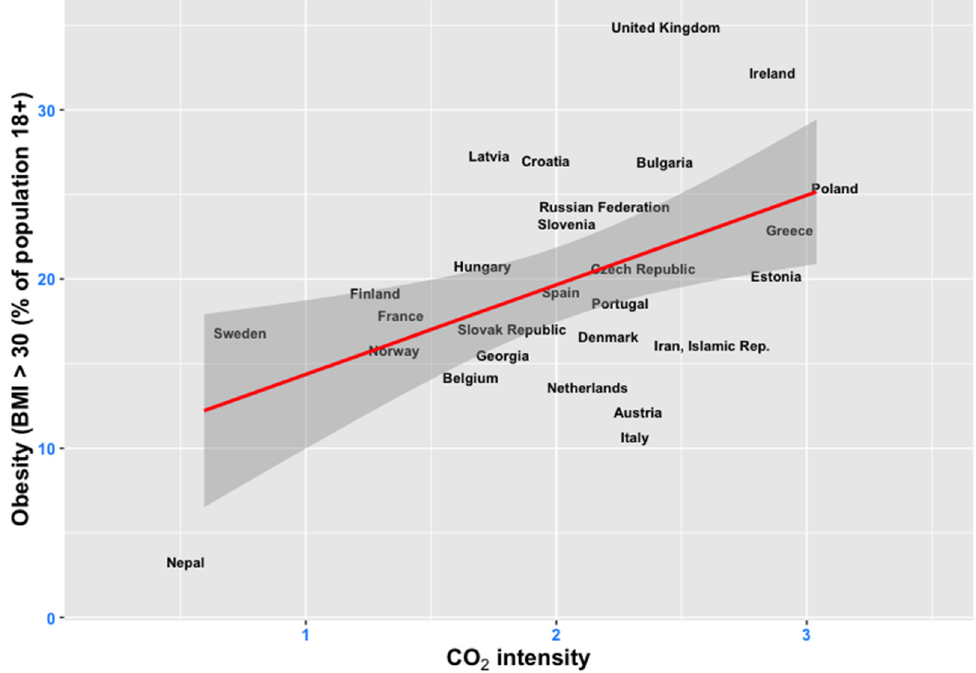
Figure 2. CO 2 intensity (kg per kg of oil equivalent energy use) and obesity (percentage of population with a BMI > 30% in all adult population) for most recent year of available data per country. The red line represents the fitted linear regression line, while the dark grey area displays the 95% confidence interval for predictions from a linear model. Source of data: World Bank’s Development Indicators (WDI) database.